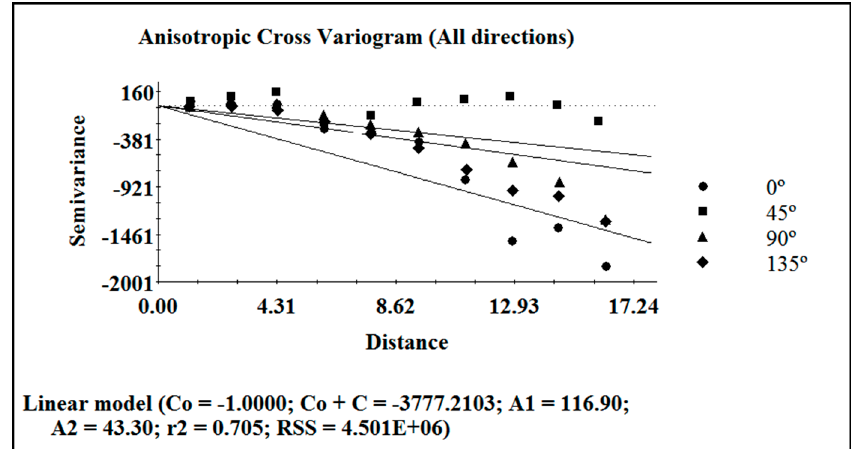
Figure 10. Spatial correlation between the Temperature and Rainfall.